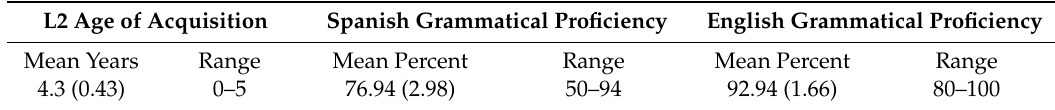
Table 1. Profile of bilingual